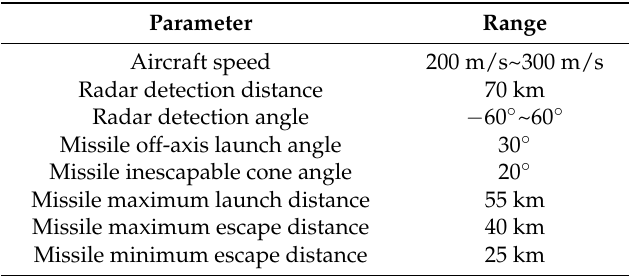
Table 3. Enemy aircraft performance.